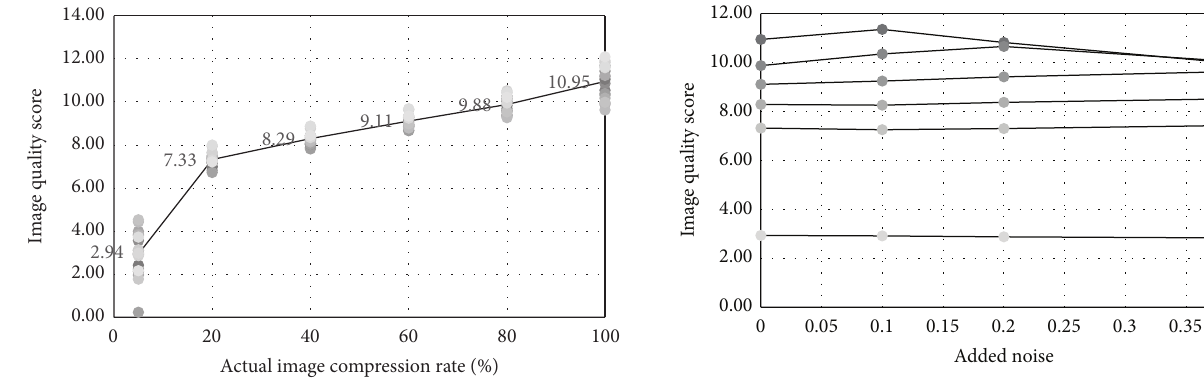
Figure 8: Image quality score in different compression rate: the numbers in the figure denote average value of quality scores of 20 pictures in the same compression rate.